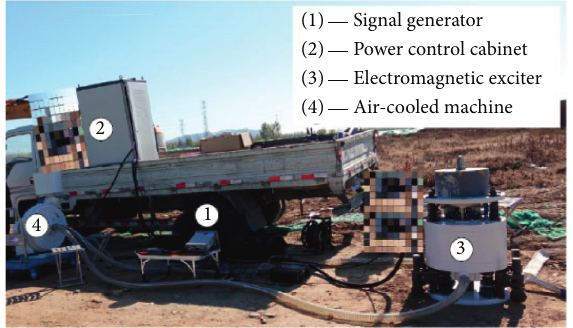
Figure 8: Electromagnetic vibration excitation system.